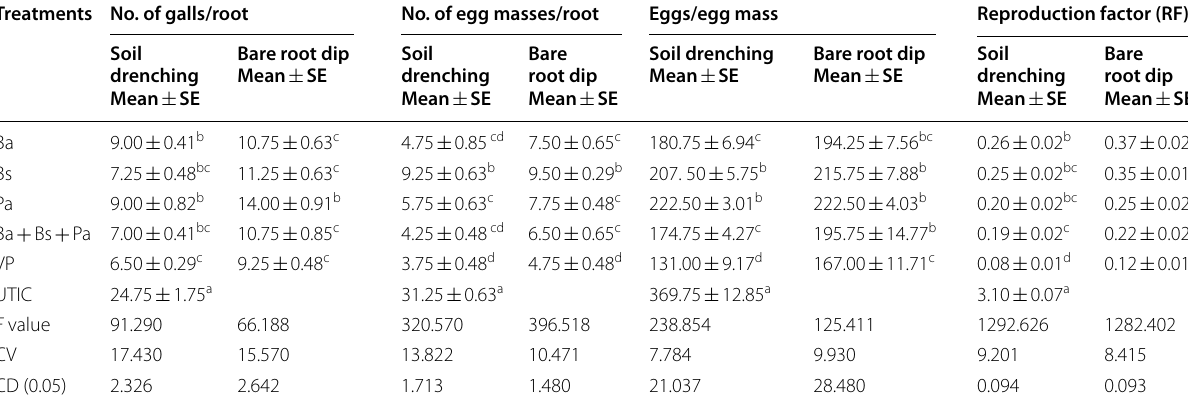
Data shown correspond to the mean of four replicates SE. Means with the same alphabet letters on each columns are not significantly ( P < 0.05 ) different. CD: Critical ± difference, CV: Coefficient of variation, SE: Standard error. Treatment details: Ba Bacillus amyloliquefaciens DSBA 11; Bs Bacillus subtilis DTBS 5, Pa Pantoea agglomerans ; Ba Bs Pa (Consortium), UTIC Untreated nematode inoculated control, VP Velum Prime ® (500 g a.i./ha) as positive control + + Table 5 Effect of PGPR isolates applied as soil drenching and bare root dipping prior transplanting on tomato plant growth infested by M. incognita under protected cultivation